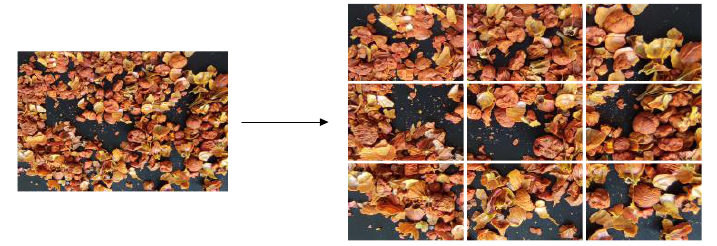
Figure 2. Images of GFP under eight different stir-frying stages. Note: C1 shows the process after 1 min, C2 shows the process after 2 min, and so on.